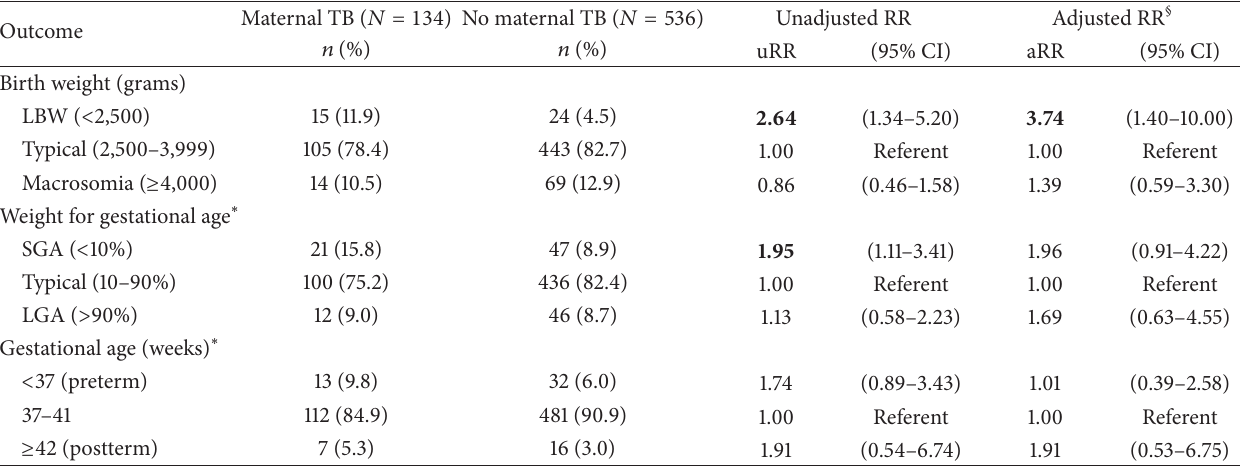
Table 2: Risk of small for gestational age, low birth weight, and prematurity for infants born to women with tuberculosis-associated ICD-9 diagnosis during delivery hospitalization, Washington State,